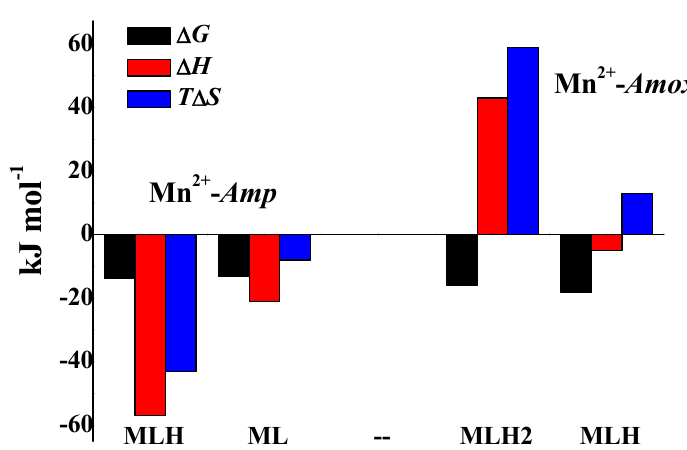
Figure 8. Bar plot of Δ G, Δ H , T Δ S referring to the Mn 2+ - Amp and Mn 2+ - Amox systems at t = 25 °C, I = 0.15 mol L − 1 in NaCl, according to the reaction (2).